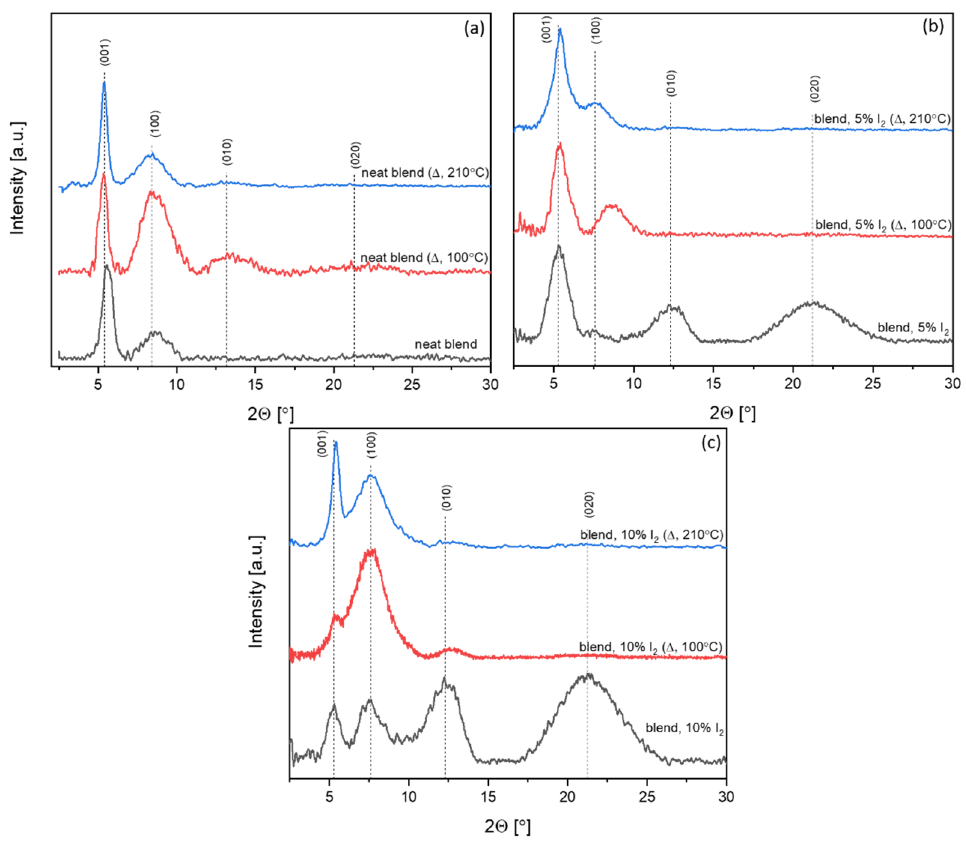
Figure 9. XRD patterns of ( a ) neat, ( b ) 5%, ( c ) 10% I 2 doped P3HT:PCBM blend before and after thermal treatment. thermal